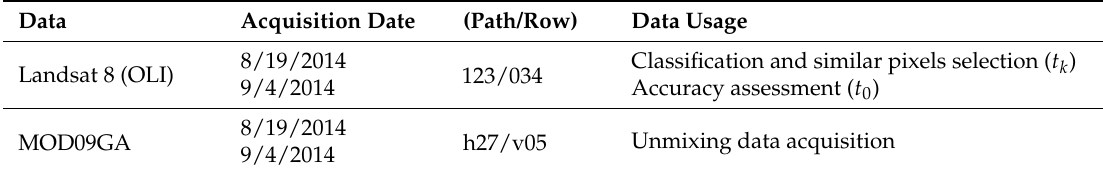
Table 1. The main characteristics of Landsat 8 and MODIS data.